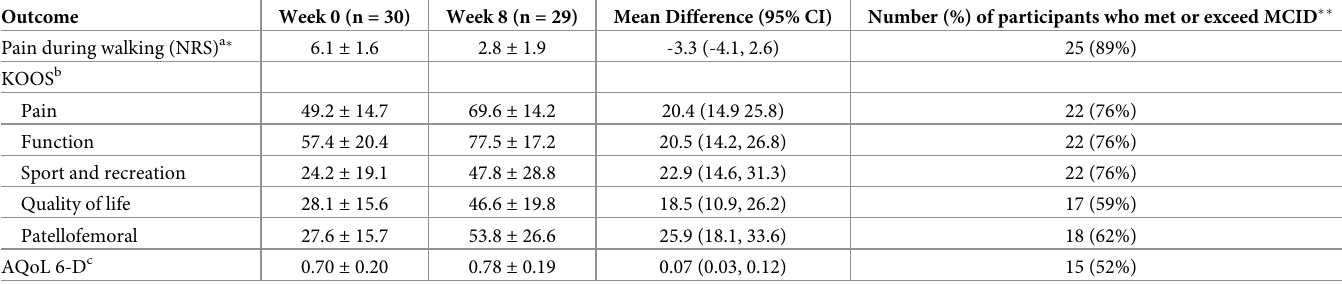
Table 4. Patient reported outcomes. Mean ± SD at week 0 and week 8 with mean difference (week 8 minus week 0) and 95% confidence intervals